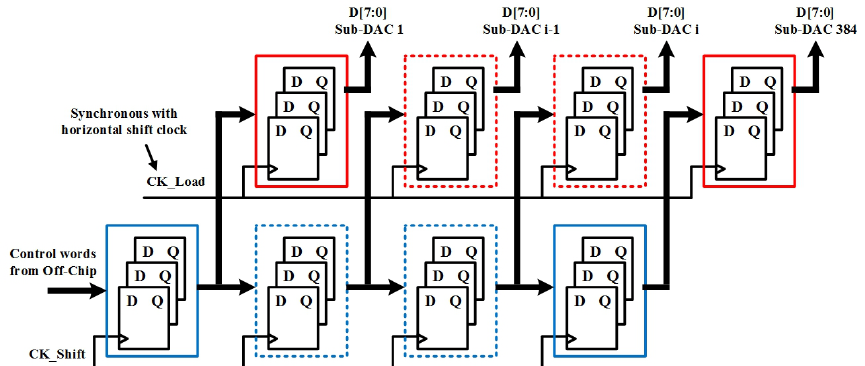
Figure 3. Two bank register arrays for correction word